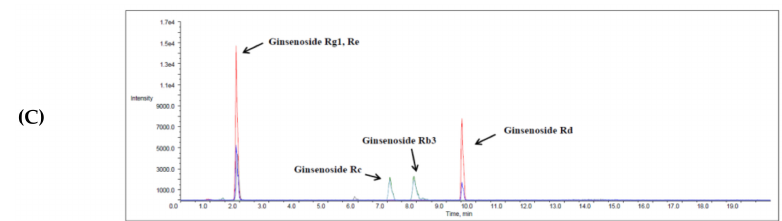
Figure5. RepresentativechromatogramsofginsenosidesRb3, Rc, Rd, Re, andRg1incalibrationstandard